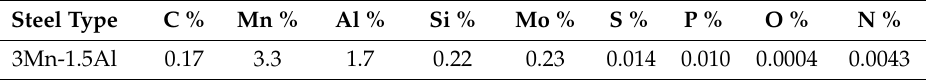
Table 1. Chemical composition of the investigated steel, in